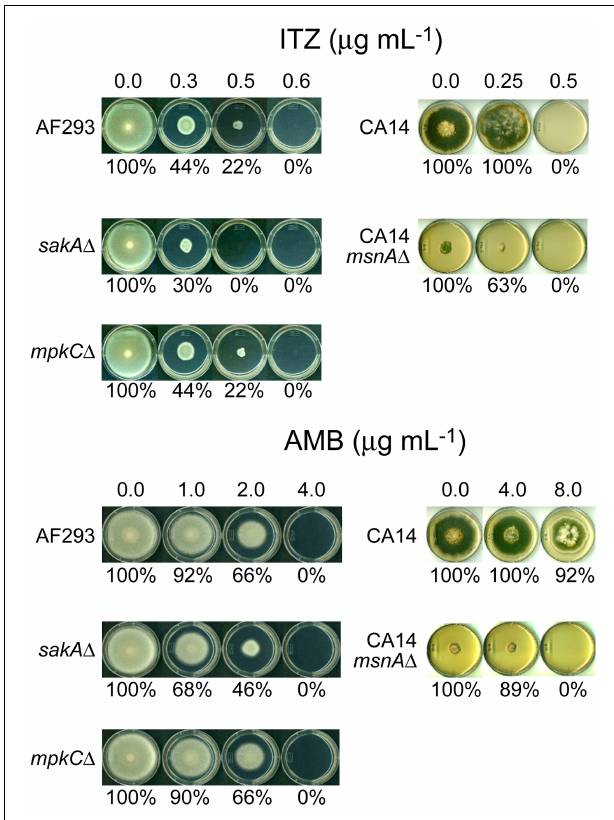
FIGURE 1 | Phenotypic responses of Aspergillus strains to antifungal drugs. A. fumigatus sakA Δ mutant was more sensitive to itraconazole (ITZ) or amphotericin B (AMB) compared to other A. fumigatus strains, i.e., AF293 (wild type) and mpkC Δ mutant. Results also showed that A. flavus CA14 msnA Δ mutant was hypersensitive to AMB compared to its parental strain (CA14), while the level of sensitivity of msnA Δ mutant to ITZ was similar to that of CA14. Percent (%) value indicated relative growth rate of “treated” compared to “not treated” control ( = 100%) in each strain (SD < 5%).